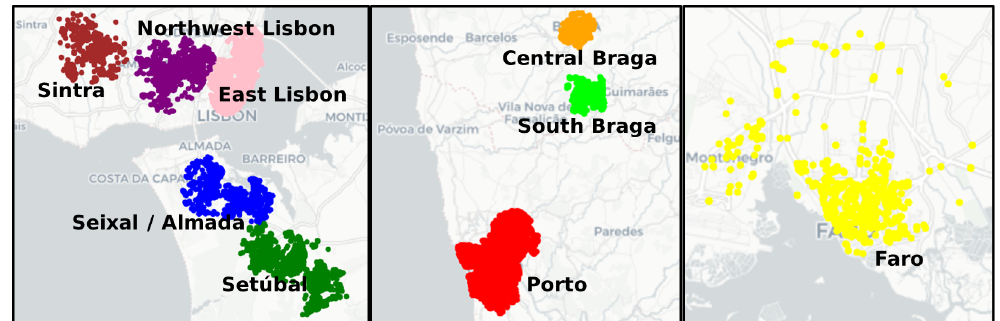
Figure 8. Dense clusters of potential inefficiency occurrence among ambulances in